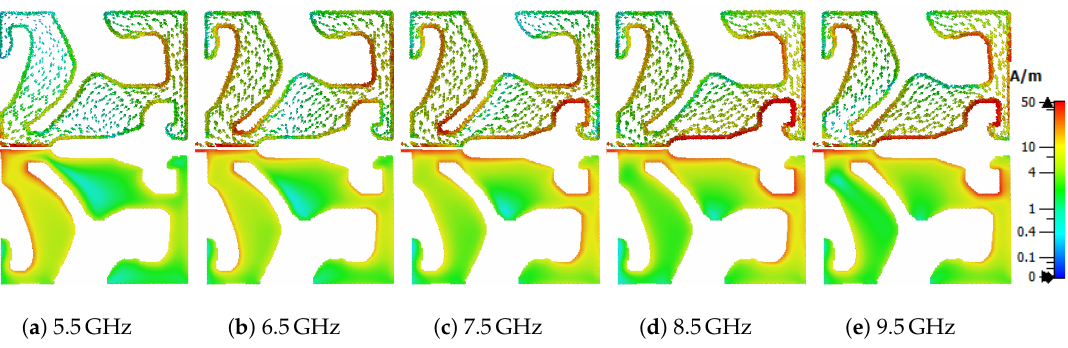
Figure 5. Surface current distribution on the reference